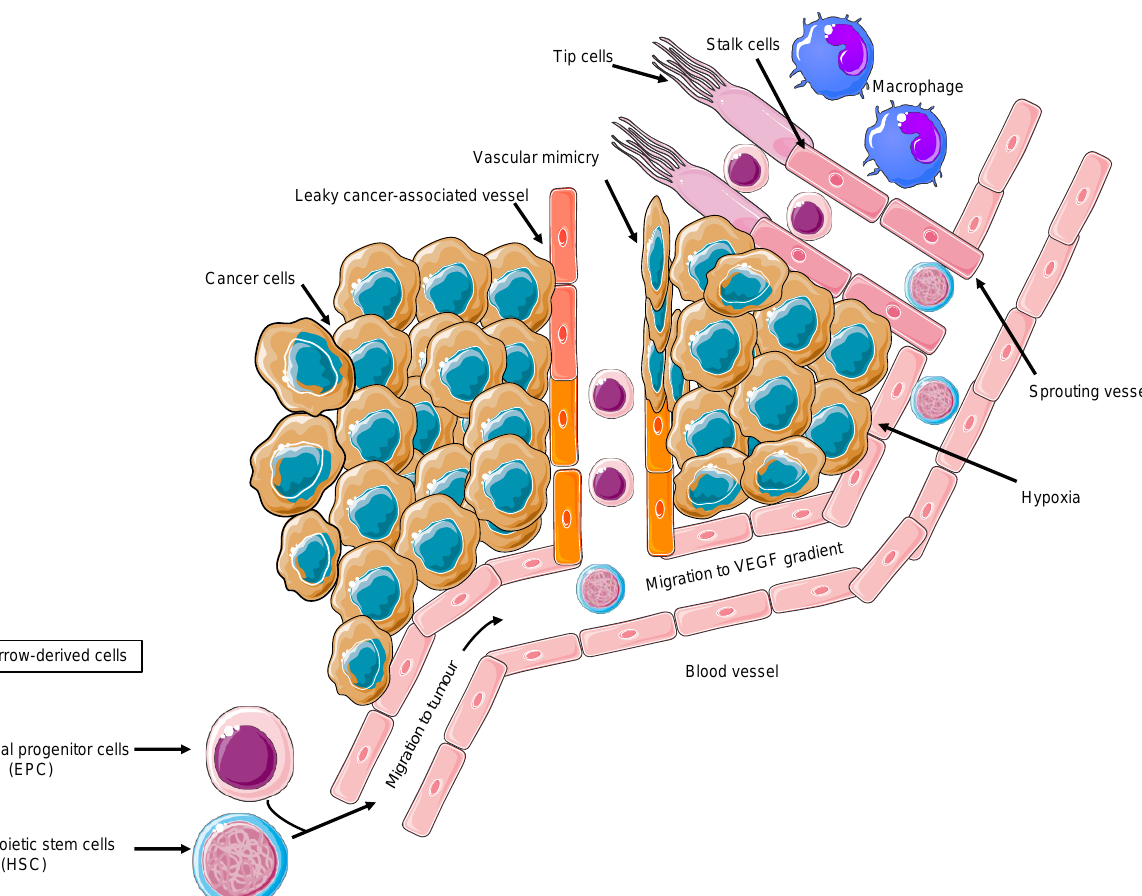
Figure 1. Cancer angiogenesis as a multi-faced, multistep process, recruiting divergent cell types and cell proliferation, migration, invasion, and differentiation, depending on the cancer-associated